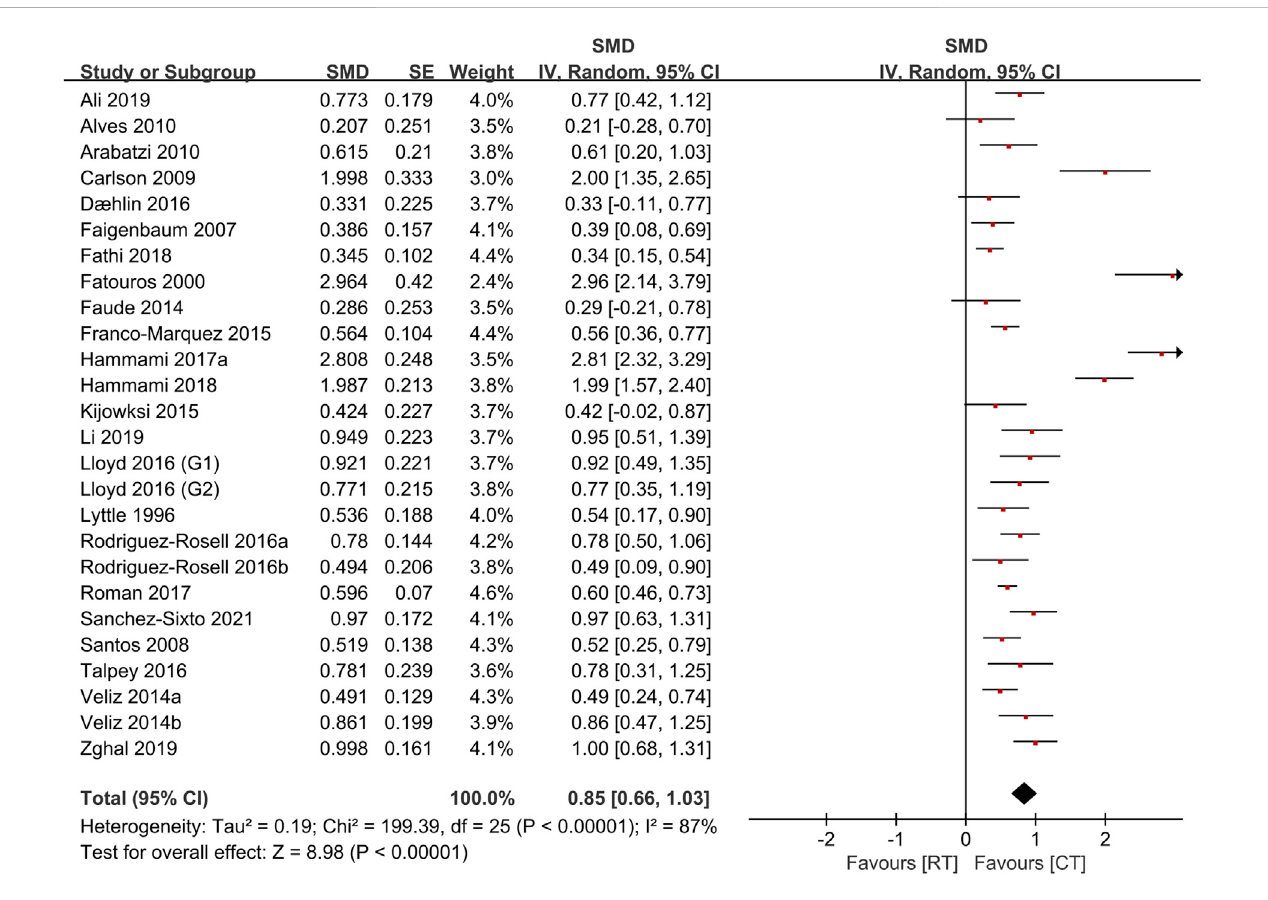
FIGURE 3 Effects of complex training (PLT) on jump